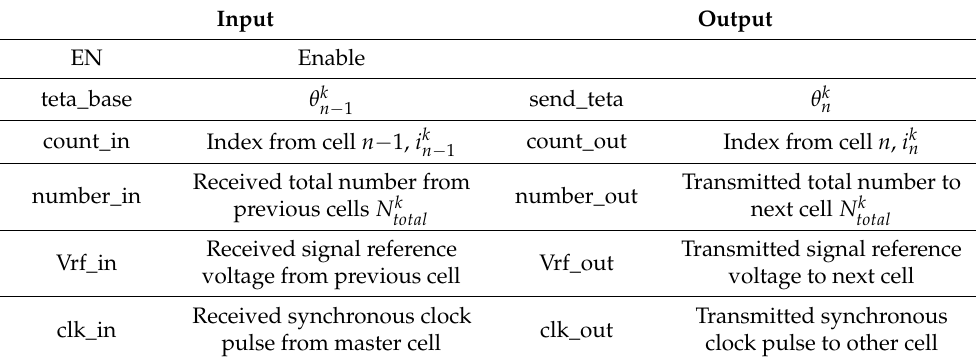
Table 1. Input and output of cell model in DSA-PSC method.